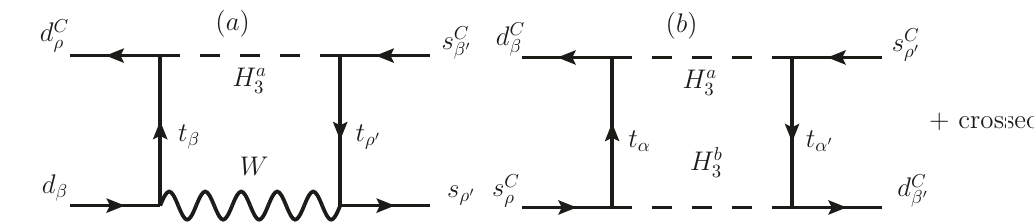
Figure 4 . Box diagrams for (cid:1) S = 2 in the diquark model, where the subscripts denote the color